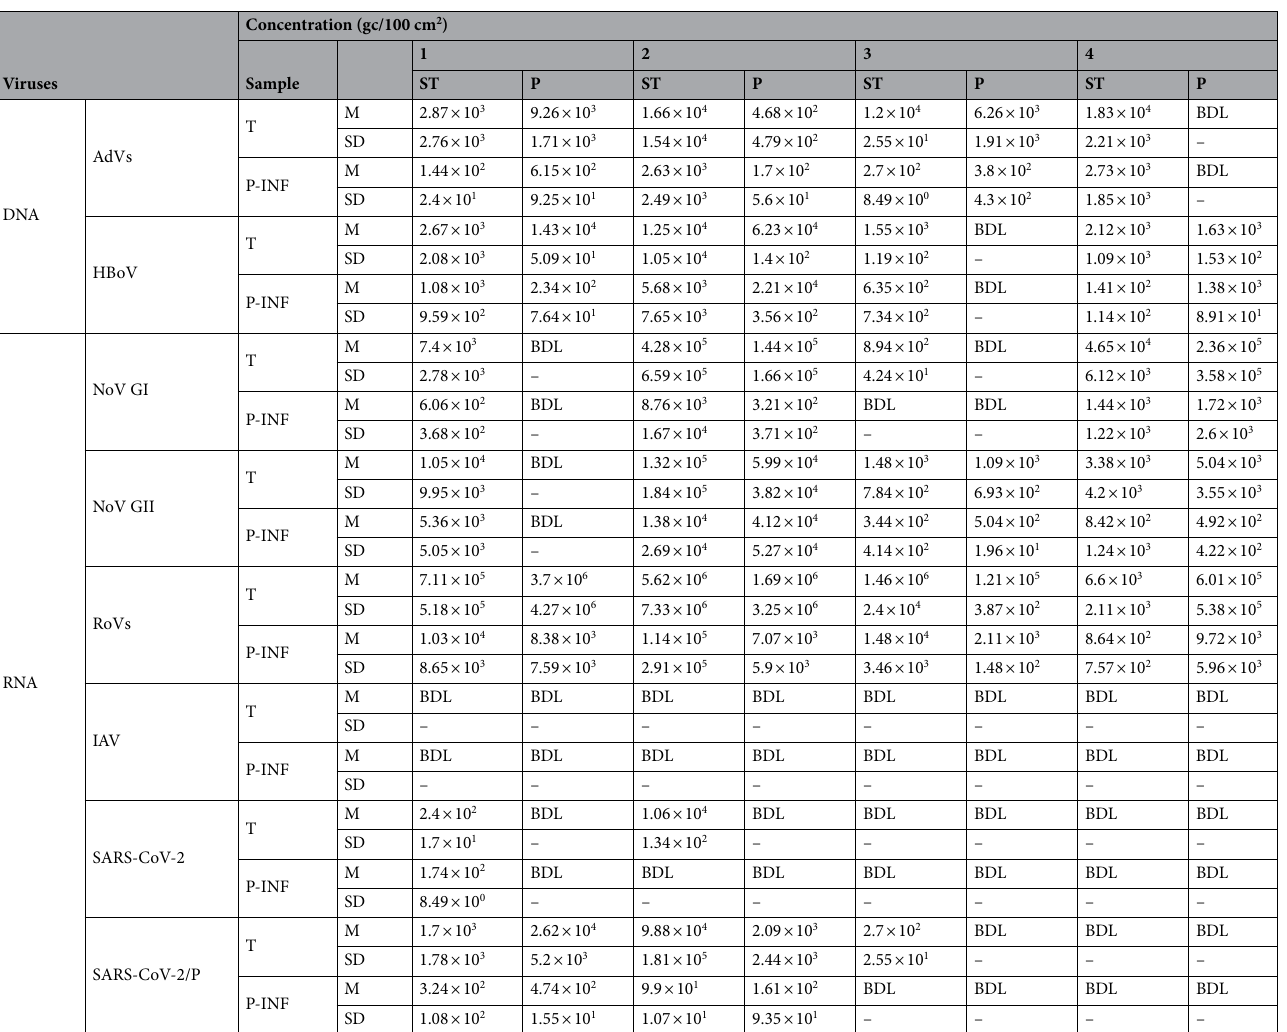
Table 7. The concentrations of DNA and RNA viruses (gc/100 cm 2 ) in positive swab samples from steel and plastic surfaces at examined WWTP sampling sites. 1 wastewater pumping section, 2 screens section, 3 grit chamber section, 4 dewatering/thickening sludge section, ST steel, P plastic, T total concentration of viruses, P‑INF concentration of potentially infectious viruses, M arithmetic mean value, SD standard deviation, BDL below detection limit, AdVs adenoviruses, HBoV human bocavirus, NoV GI Norwalk virus genogroup I, NoV GII Norwalk virus genogroup II, RoVs rotaviruses, IAV influenza A virus, SARS‑CoV‑2 severe acute respiratory syndrome coronavirus 2, SARS‑CoV‑2/P presumptive SARS-CoV-2 positive/other coronaviruses